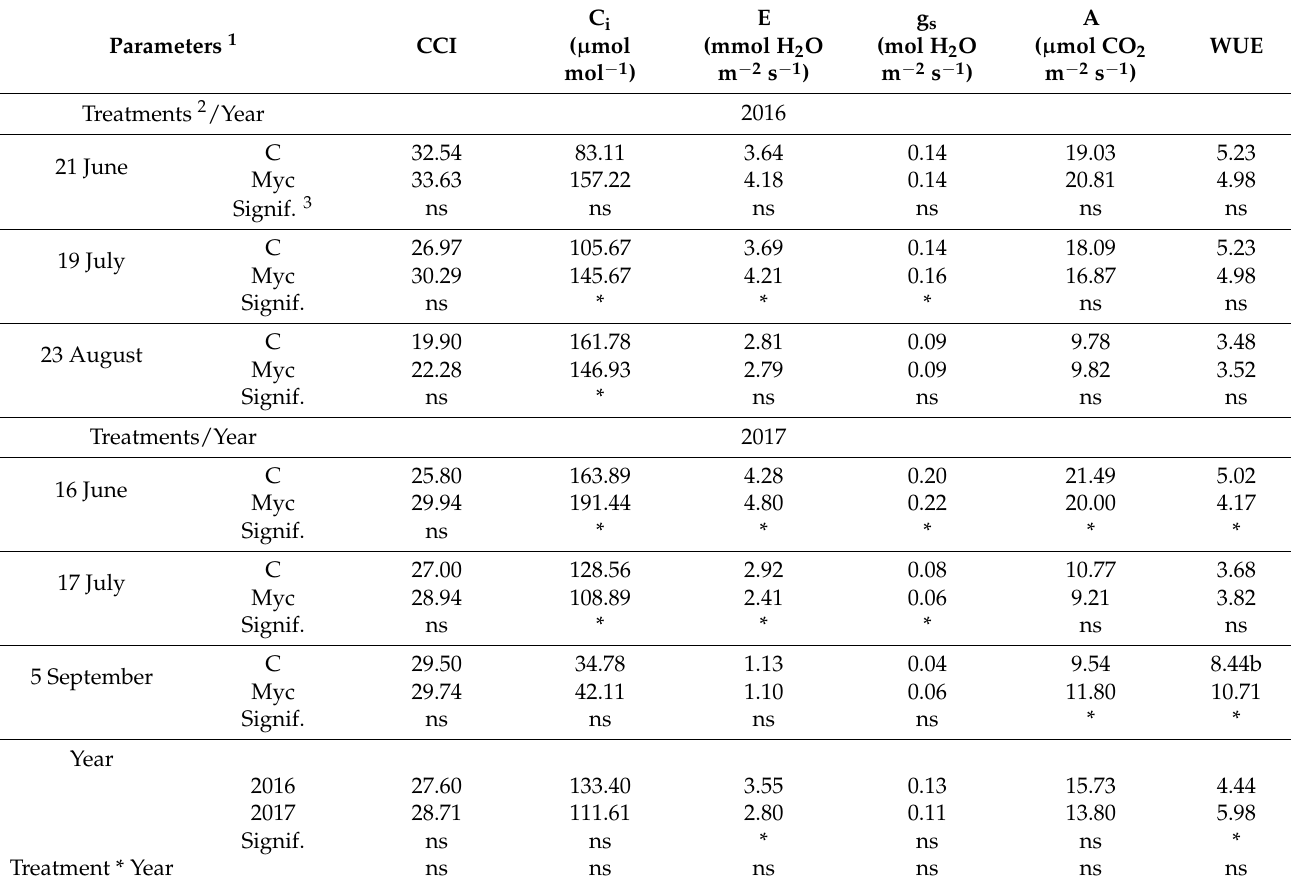
Table 2. Leaf gas-exchange measurements in mycorrhized and control treatments.